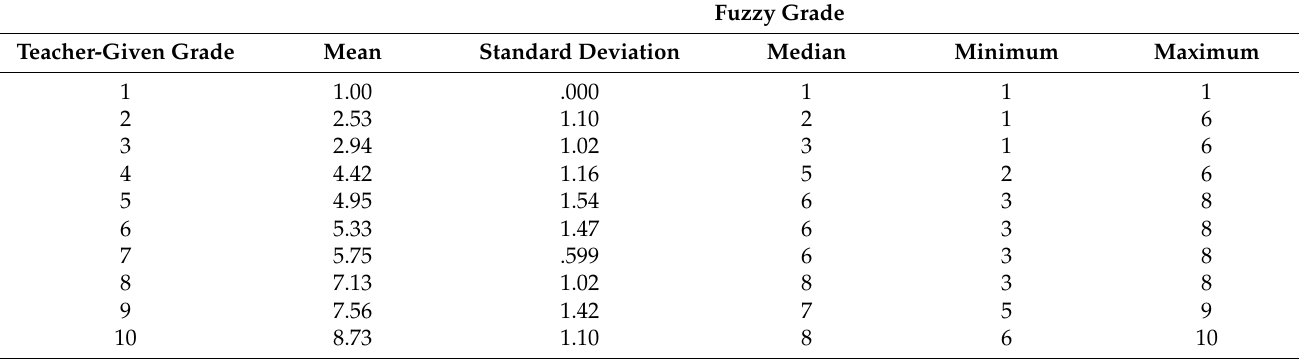
Table 11. Descriptive statistics for fuzzy grades among the levels of teacher-given grades. Fuzzy